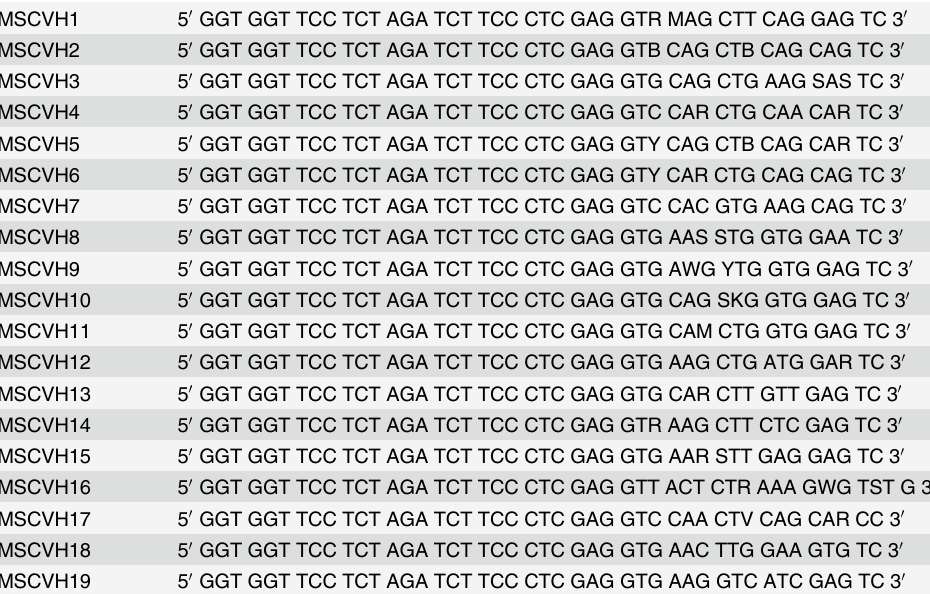
Table 5. V H 5' Sense primers: MSCVH1-MSCVH19 for construction of a murine scFv library (pCOMB3xSS). MSCVH1